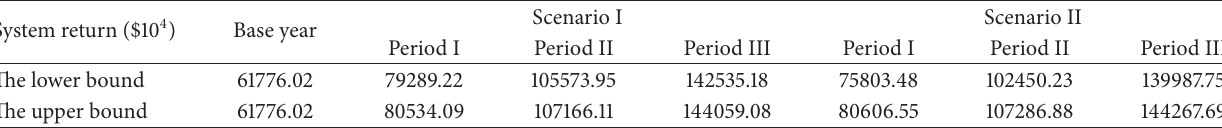
Table 3: The system returns of ILP model.